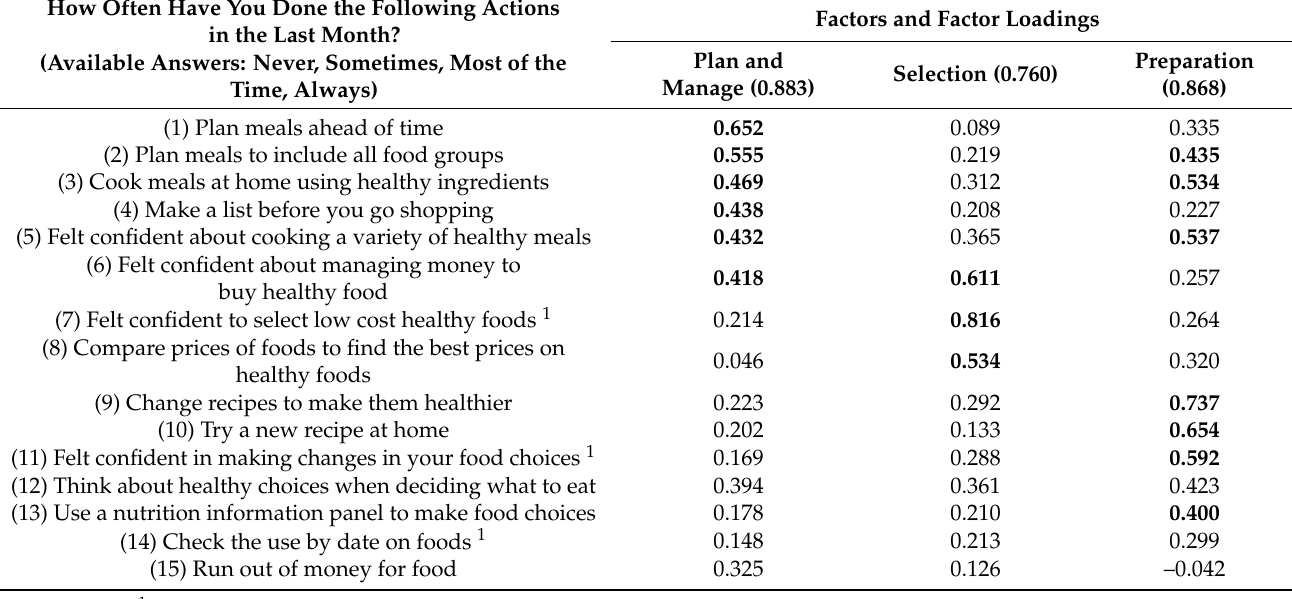
Table 3. Revised food literacy behavior checklist, factors, and factor loadings ( n = 1359). The three columns alongside show the scores of the items for each of the three factors. The scores above the threshold of 0.4 were accepted in the factors (shown in bold font) and Cronbach’s alpha analyses, indicated in parentheses following each factor